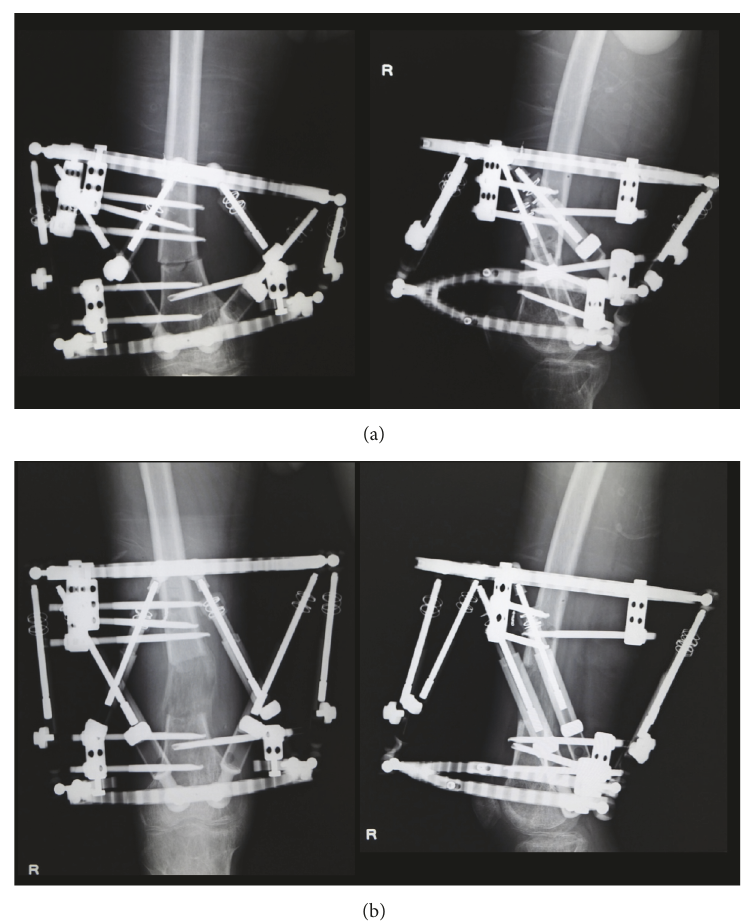
Figure 4: Reconstruction of multidirectional deformity by using the hexapod external fixator system. (a) Application of a hexapod external fixator; (b) completion of the reconstruction